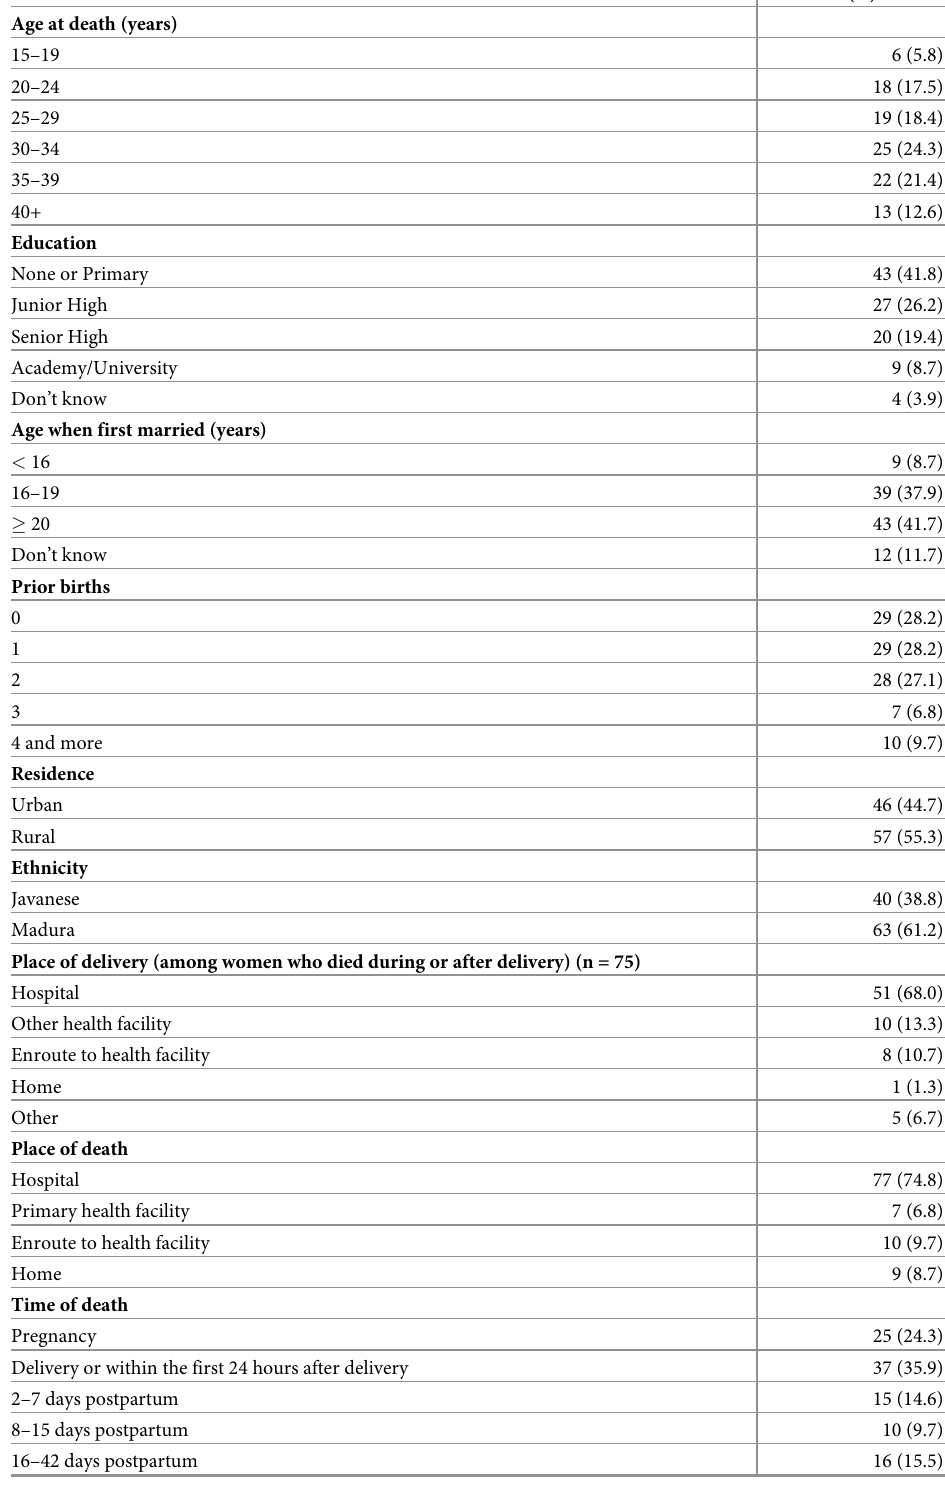
Table 1. Characteristics of pregnancy-related death cases (n = 103) in Jember District,